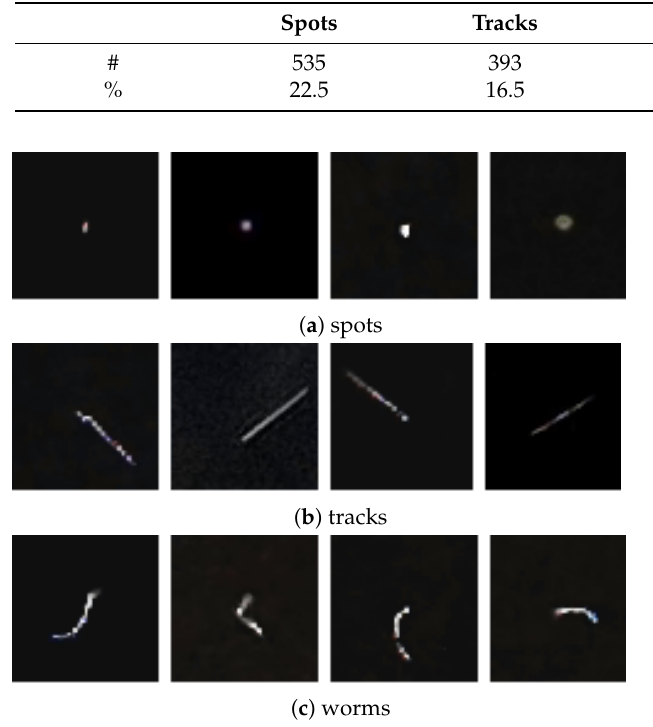
Figure 2. Four representatives of spots ( a ) , tracks ( b ) and worms ( c